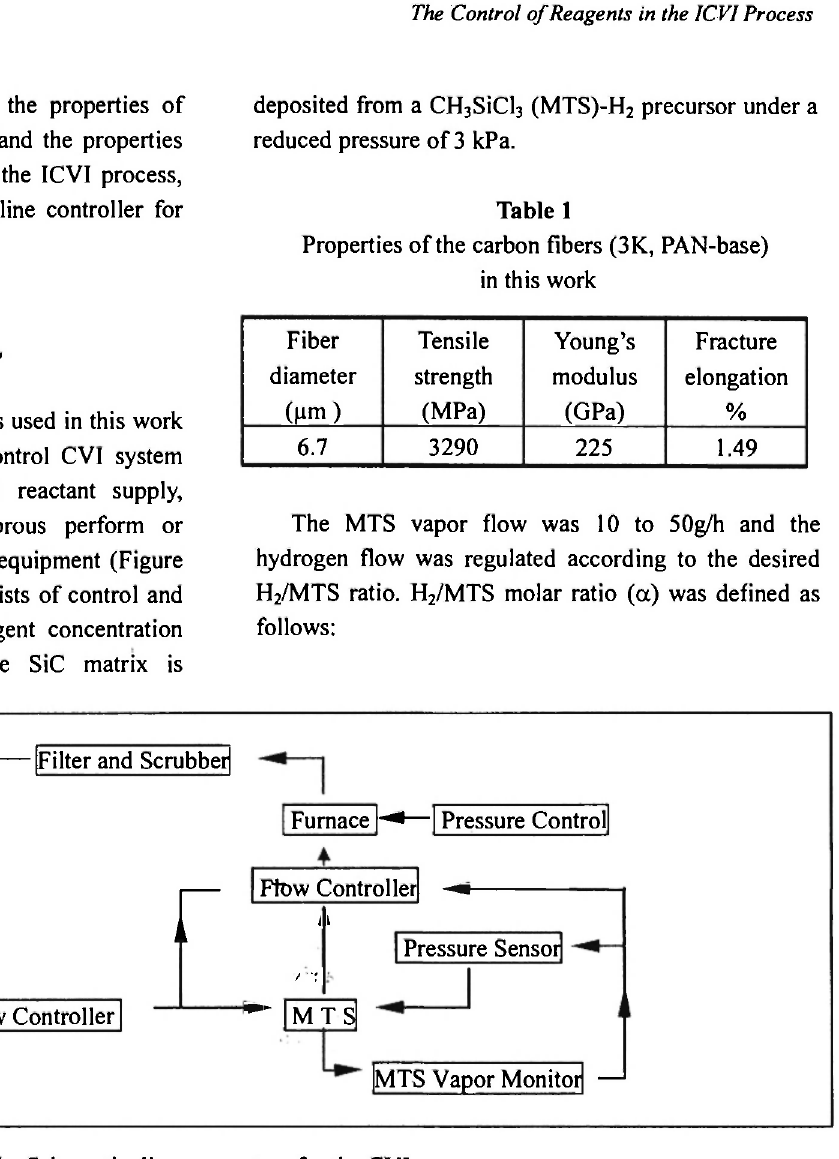
Fig. 1: Schematic diagram system for the CVI